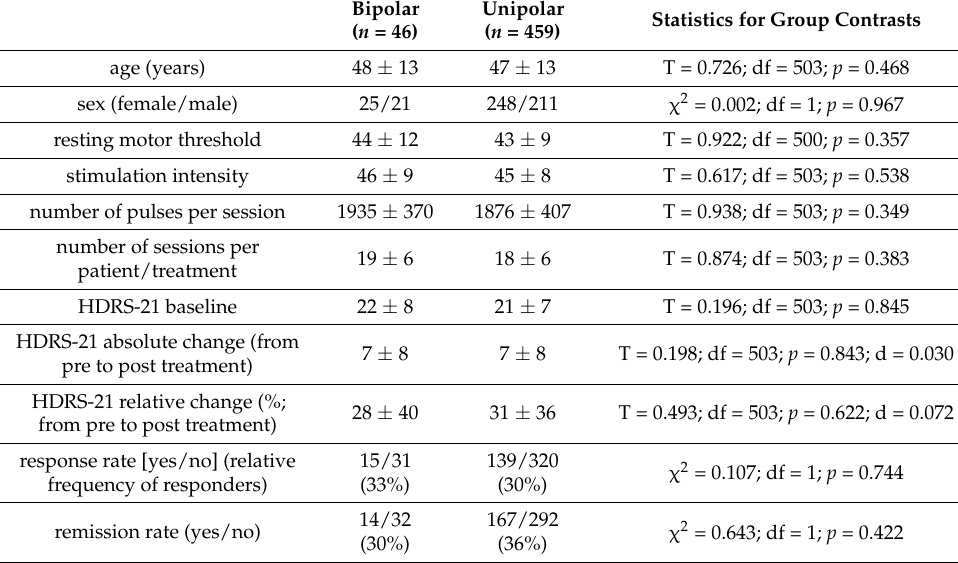
Table 1. Characteristics of patients with depression.